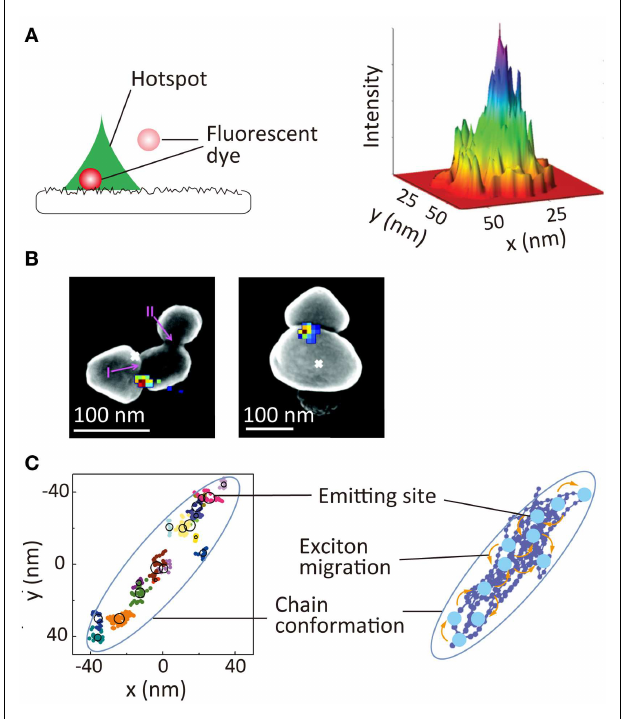
FIGURE 6 | Super-resolution imaging of optical properties of nanoscale architectures. (A) Super-resolution imaging of local electromagnetic field enhancement. (Left) principle of Brownian motion super-resolution imaging; (right) super-resolution image of a hotspot on the surface of an aluminum film (Cang et al., 2011). (B) Super-resolution image of SERS signal of rhodamine 6G dyes adsorbed at gap between two silver nanoparticles. Overlay of the SERS spatial intensity map (colored pixels) and luminescent centroid (white × ) with an SEM image of silver nanoparticle aggregate (Weber et al., 2012). (C) (Left) schematic illustration nanoscale photophysical processes occurring in a single conjugated polymer molecule. (Right) 2D spatial map of emitting sites within a single conjugate polymer chain; reproduced with permission from Cang et al. (2011), copyright 2011, Nature Publishing Group (A) ,Weber et al. (2012), copyright 2012, American Chemical Society (B) , Habuchi et al. (2011), copyright 2011, PCCP Owner Societies (C)